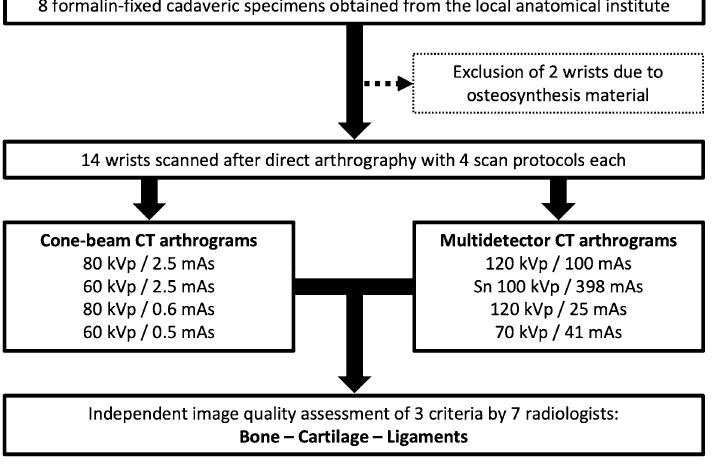
Figure 1. Flow chart illustrating the study